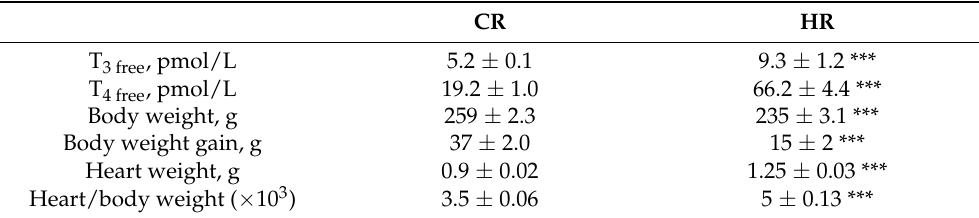
Table 2. T 3 (free) and T 4 (free) concentrations and body and heart weights in the control and hyperthyroid rats.